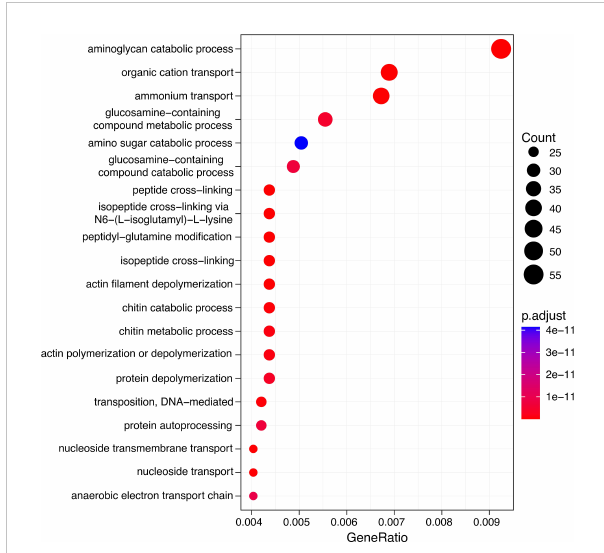
FIGURE 7 Gene ontology (GO) analysis of differentially abundant genes in plankton extract treatment compared to